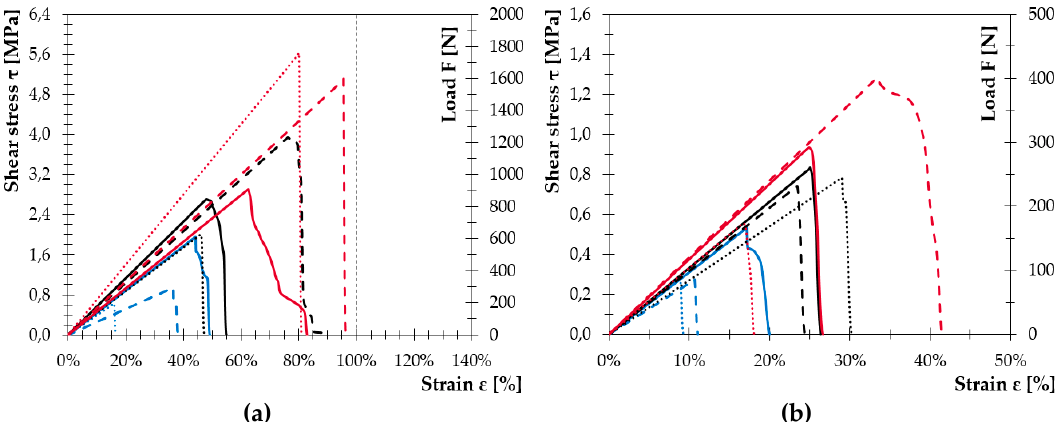
Figure 10. Comparison of average stress–strain curves from shear test: ( a ) samples with primer and ( b ) samples without primer. Color marking: RED — WPC_45/45; BLACK — WPC_60/30; BLUE — WPC_58/30. Solid lines are samples with mechanical treatment, dashed lines are samples with physical treatment and dotted lines are samples with chemical treatment.